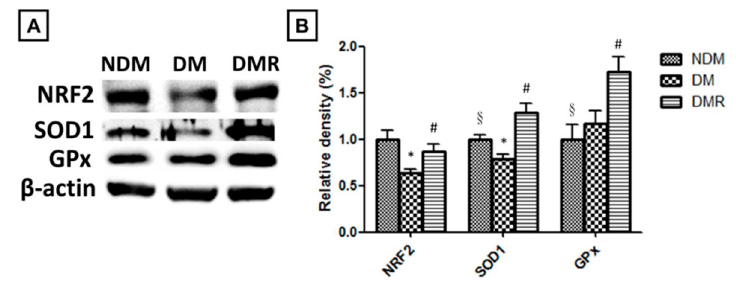
Figure 6. The expression of NRF2-related antioxidant enzymes was analyzed by Western blotting ( A , B ). * p < 0.05 DM compared with the NDM group, § p < 0.05 DMR compared with the NDM group, and # p < 0.05 DMR compared with the DM group.